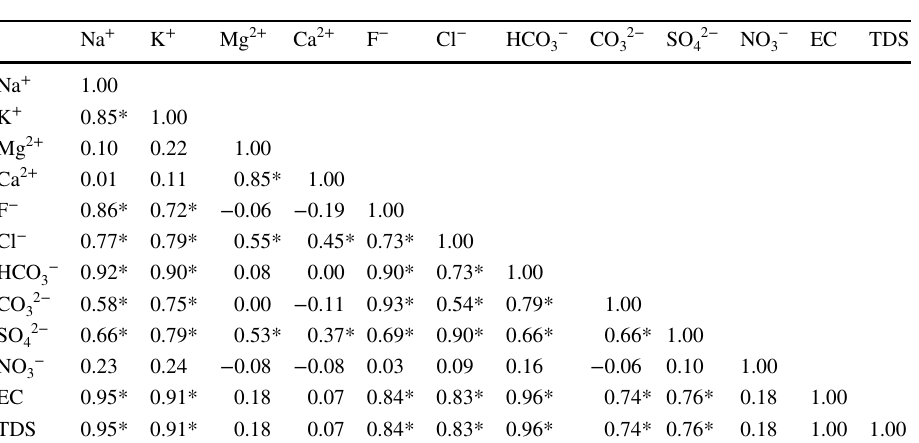
*Correlation is significant at the 0.01 level